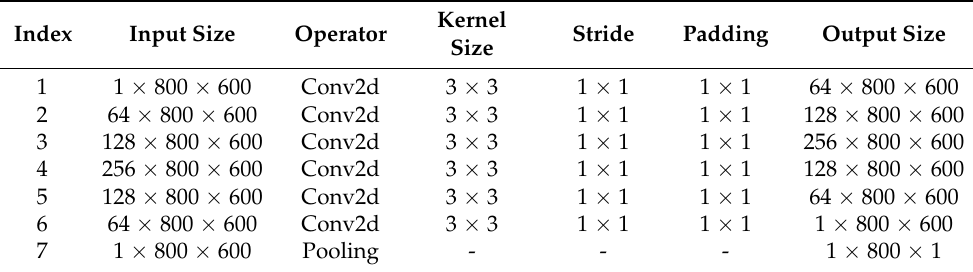
Table 1. Detailed overall CNN architecture